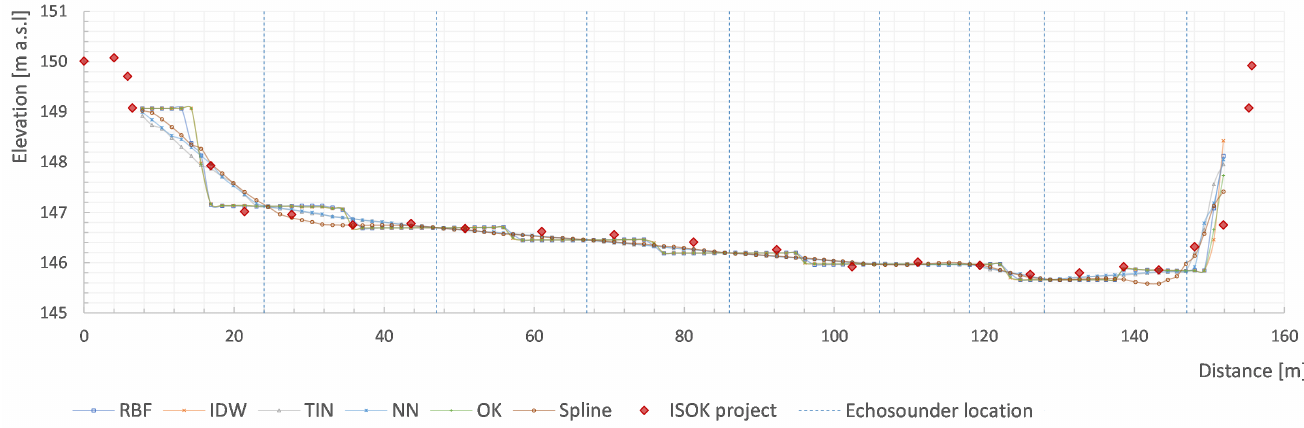
Figure 11. Cross-section of the km 157 + 020. Cross-section A (XS A) displayed in Figure